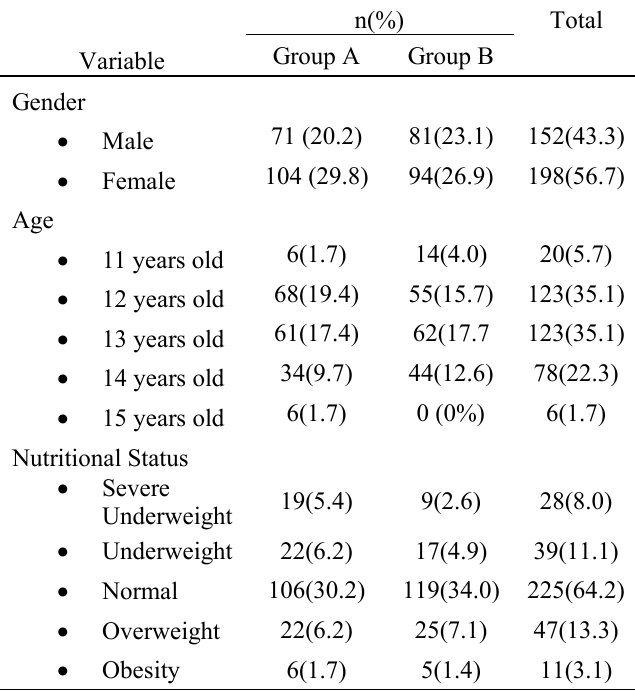
Table 1 Characteristics of respondents from Junior High School